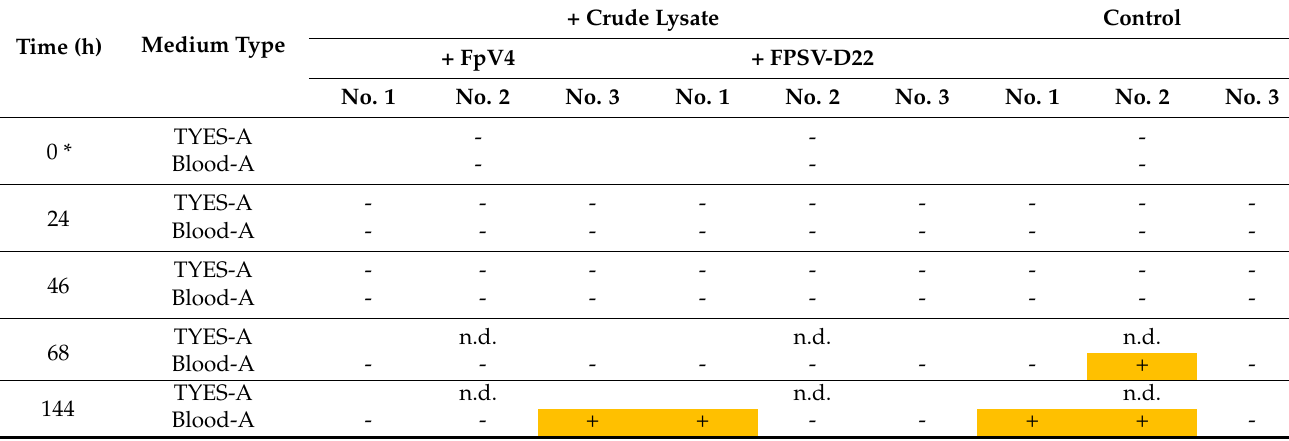
Table A4. Exp. II section B. Bacterial growth in the well of sampled eyed eggs was assessed during the experiment. A plus symbol with an orange background indicates a positive detection of bacterial colonies in TYES-B and/or on Blood-A (“-” = no growth). F. psychrophilum was not